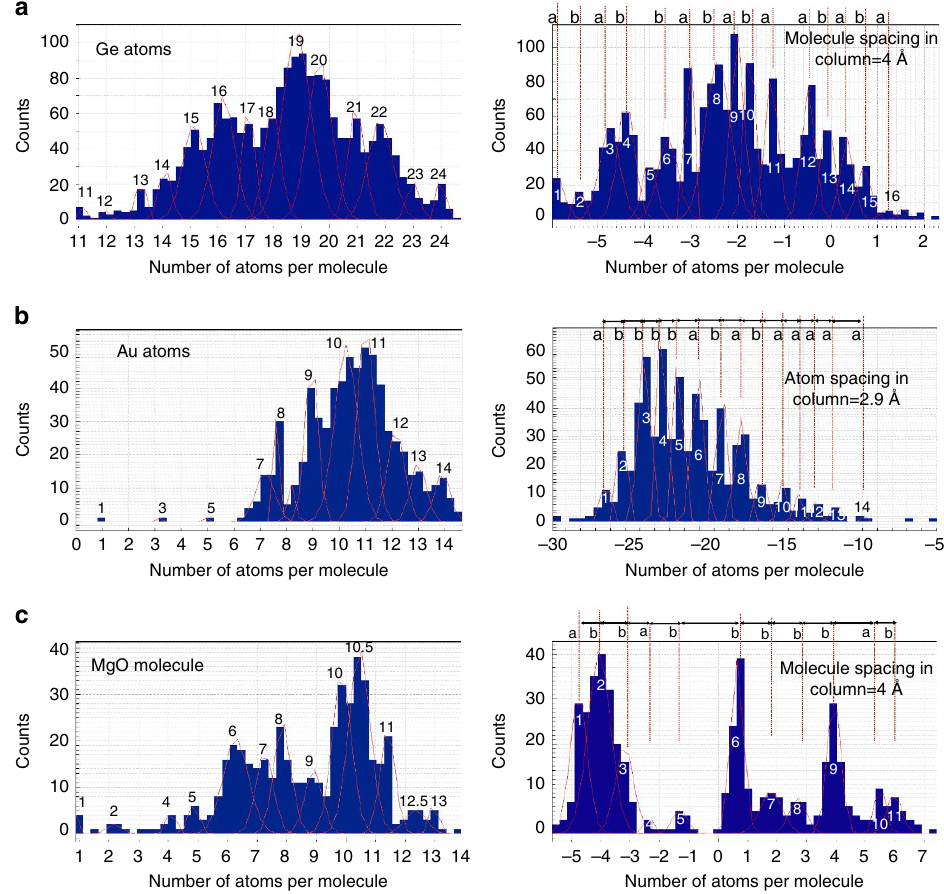
Figure 3 | Column mass and focus histograms. ( a ) Germanium and ( b ) gold values are given in terms of single atoms. ( c ) MgO graphs refer to single molecules. Gaussian functions (red lines) are fitted to their width, which is given in form of an averaged 2* s error bar in Table 1. In focus graphs, the number of atoms/molecules are converted into focus values by multiplication with their listed spacing in beam direction. For germanium and gold, a and b sites refer to the existing (110) surface corrugation. In case of MgO [100], a surface corrugation is absent but surfaces are either terminated by Mg or by O